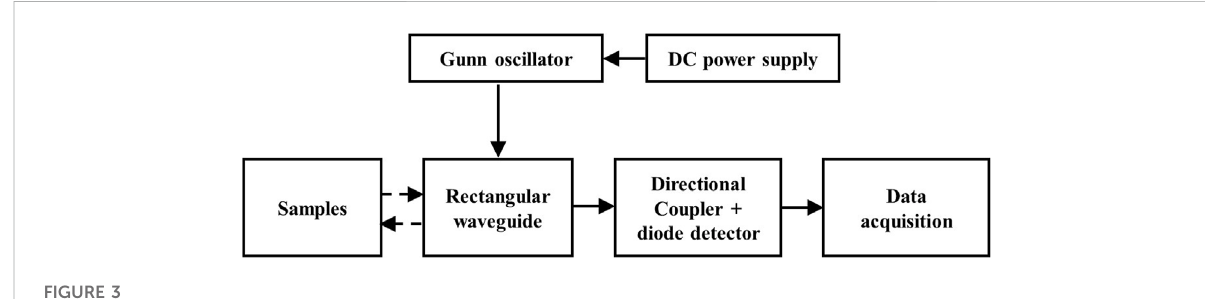
FIGURE 3 Working principle of the microwave-based test system (Lutz et al.,2012).